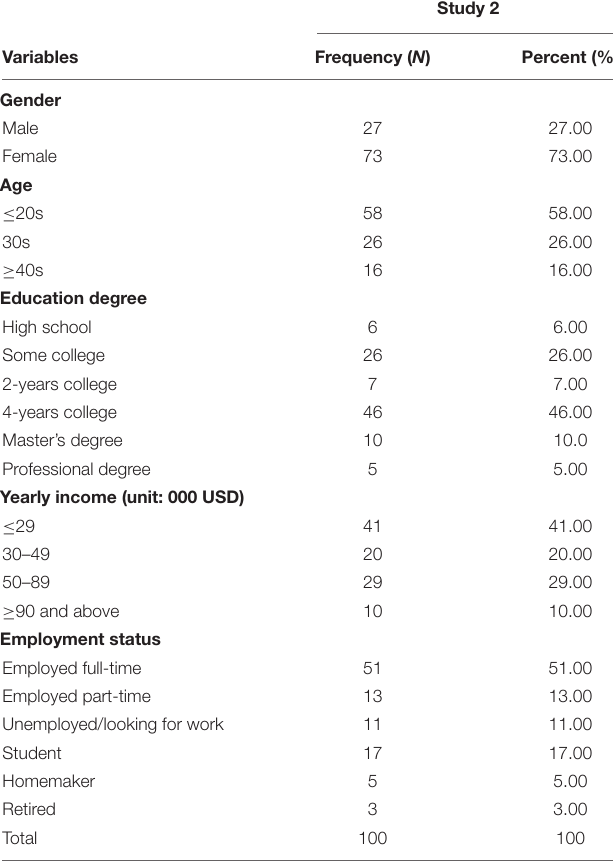
TABLE 2 | Sample demographic for study